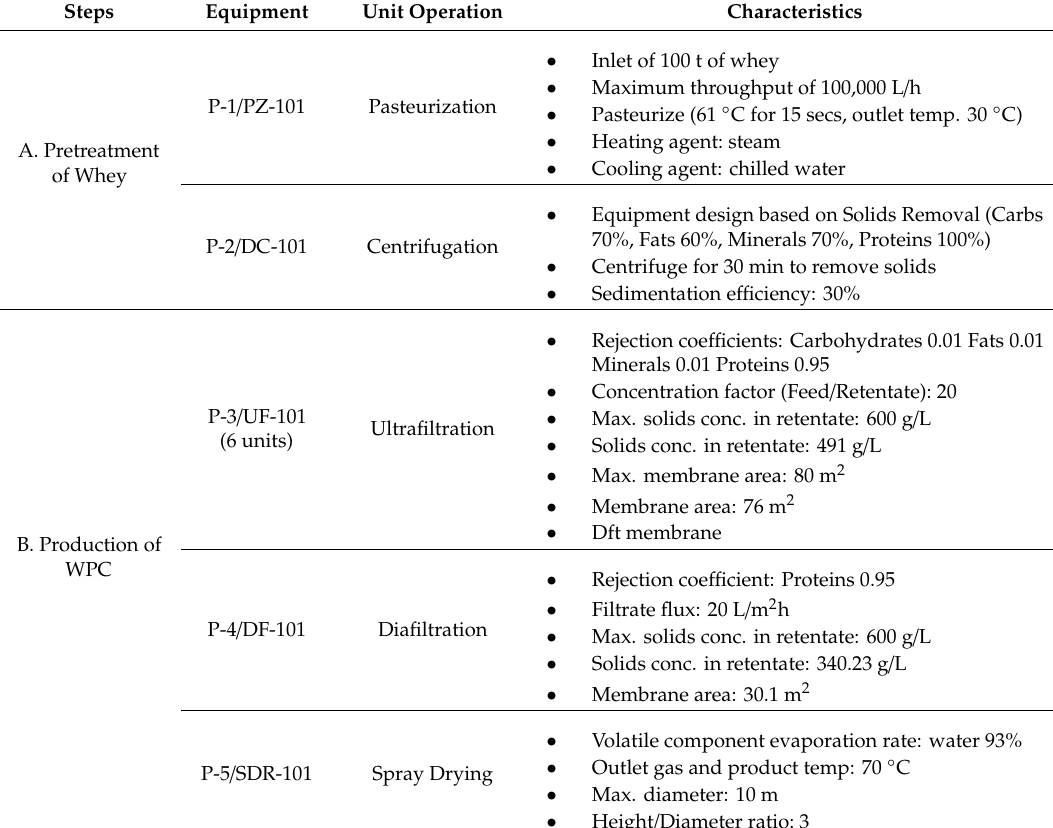
Table 1. Information provided on the equipment necessary for processing of whey and production of plastic in the models